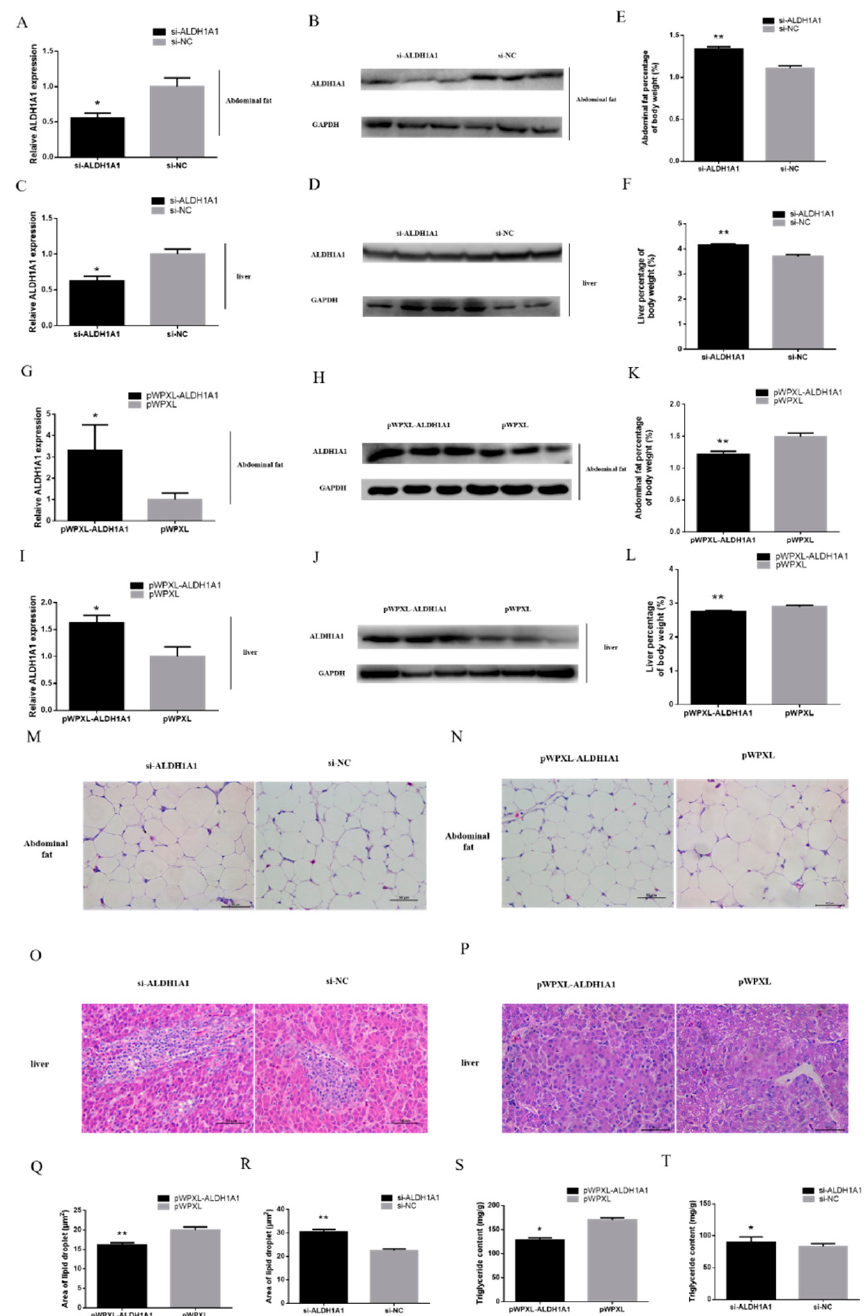
Figure 6. ALDH1A1 inhibits fat-depot in chickens. ( A – D ) ALDH1A1 mRNA relative expression ( n = 12) and protein level in abdominal fat and liver after interfering lentivirus injection for a week. ( E , F ) Abdominal fat percentage and mass of liver after interfering lentivirus injection for a week ( n = 12). ( G – J ) ALDH1A1 mRNA relative expression ( n = 9) and protein level in abdominal fat and liver after overexpression lentivirus injection for a week. ( K , L ) Abdominal fat percentage and mass of liver after overexpression lentivirus injection for a week ( n = 9). ( M – P ) The slices of abdominal fat and liver from di ff erent groups, scale bar: 50 µ m. ( Q , R ) The area of lipid droplets in abdominal fat from di ff erent groups analyzed by ImageJ. ( S , T ) The triglyceride accumulation in abdominal fat from di ff erent groups. In all panels, data are presented as the mean ± S.E.M. of three biological replicates. The statistical significance of di ff erences between means was assessed using an unpaired Student’s t -test (* p < 0.05; ** p < 0.01) vs. NC.